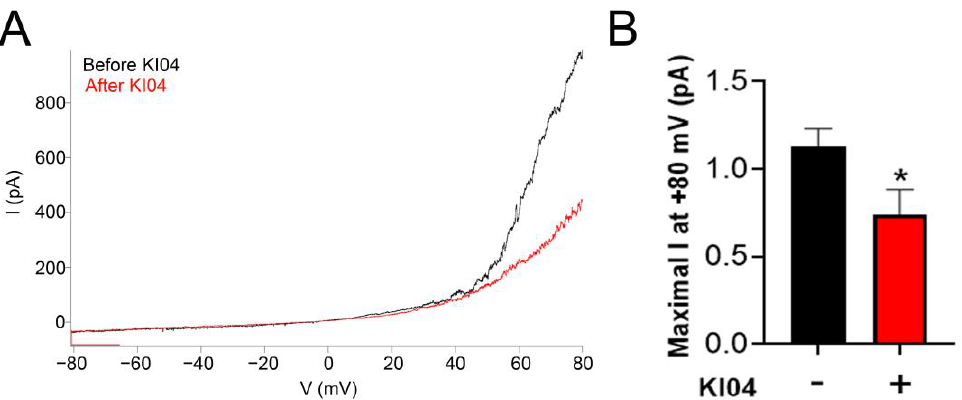
Figure 4. KI04 inhibits Cx46-mediated hemichannel currents. Hemichannel currents were studied in HeLa cells expressing Cx46tGFP. ( A ) Voltage ramps from − 80 to +80 mV were applied in